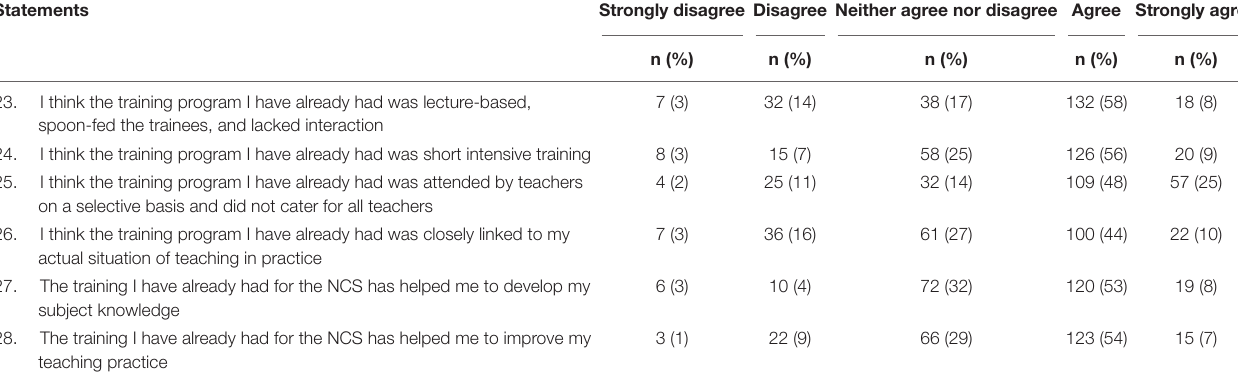
TABLE 3 | Teachers’ attitudes toward teacher training for the NCS.